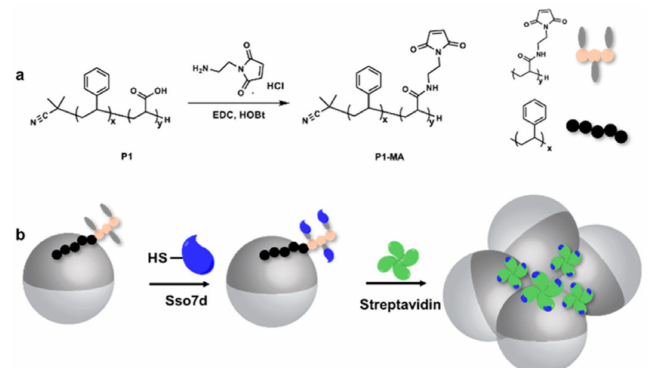
Figure 17. Functionalization of the droplets with the polymer surfactant. ( a ) Synthesis of maleimide functionalized surfactant P1-MA from a polystyrene-b-poly(acrylic acid) polymer. ( b ). Bioconjugation of rcSso7d to the droplet H/W interface via maleimide–thiol chemistry. The addition of streptavidin to the rcSso7d-functionalized droplets assay cause agglutination. The hydrocarbon phase is shown in dark gray for display purposes. Reprinted with permission from ref. [121] Copyright © 2019 American Chemical